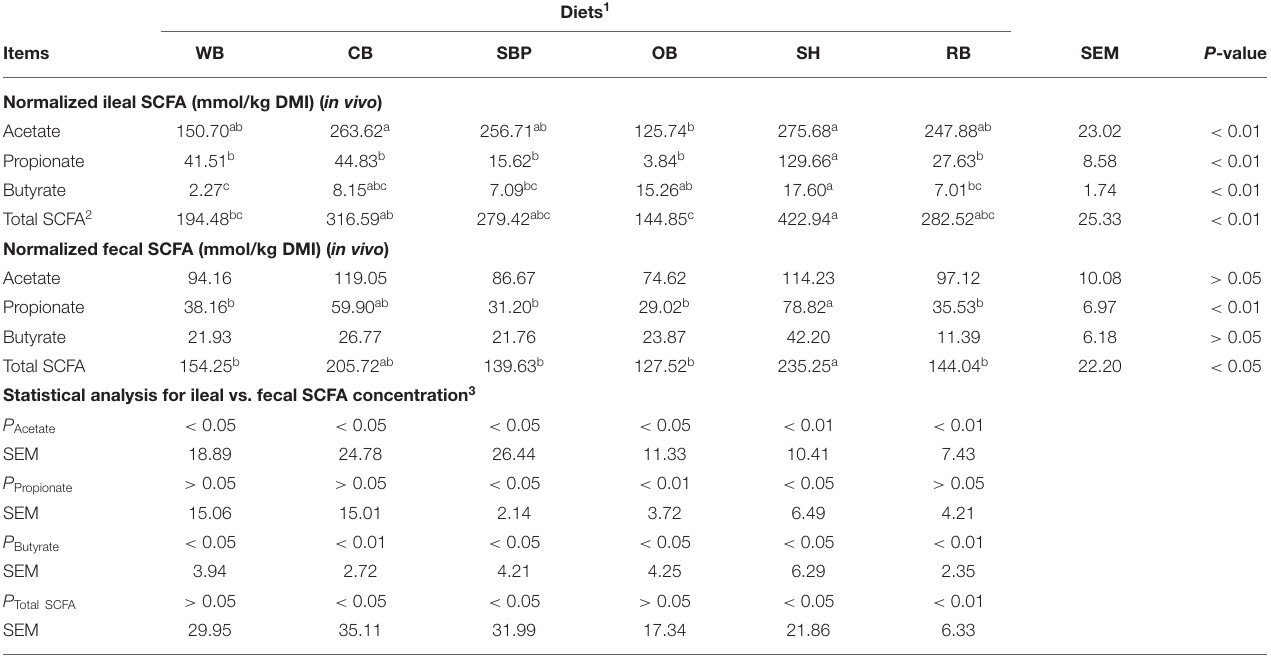
TABLE 2 | Normalized ileal and fecal SCFA concentration for ileal cannulated pigs fed diets containing different sources of fiber ( n = 6 per group). Diets